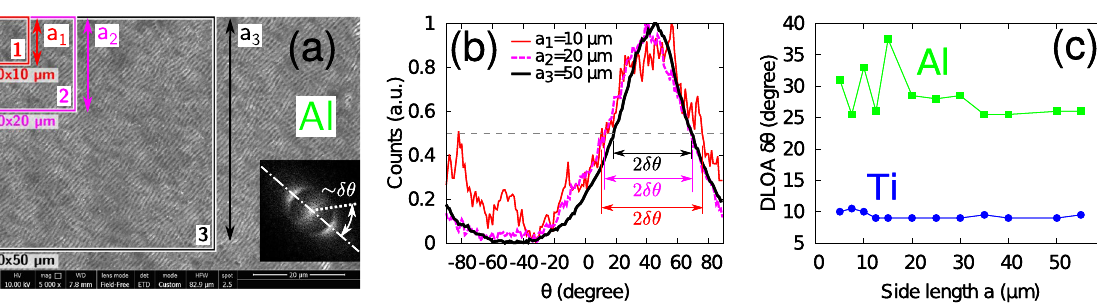
Figure 6. Effect of the measurement area on the DLOA δθ . For different sizes of the LIPSS-covered area chosen for analysis ( a ), different spectra ( b ) of orientations θ can be obtained with the module OrientationJ 23 of the open software ImageJ 59 . The normalized spectra of orientation are shown for the case of Al. The orientation axis ranges from − 90° to + 90° (orientation is π -periodic: the orientation angle of + 91° corresponds to the orientation of − 89°). Note that on ( b ) the distribution is centered around 45°, in line with the LIPSS orientation on ( a ). Colors of lines in ( b ) correspond to areas in ( a ) highlighted by the same colors. ( c ) Good convergence of the DLOA measurements is achieved when the surface area selected for analysis is large enough. Side length a refers to the square area (of side a i , i = 1, 2, 3) in Fig. ( a ) The measurement performed on Ti is also reported for